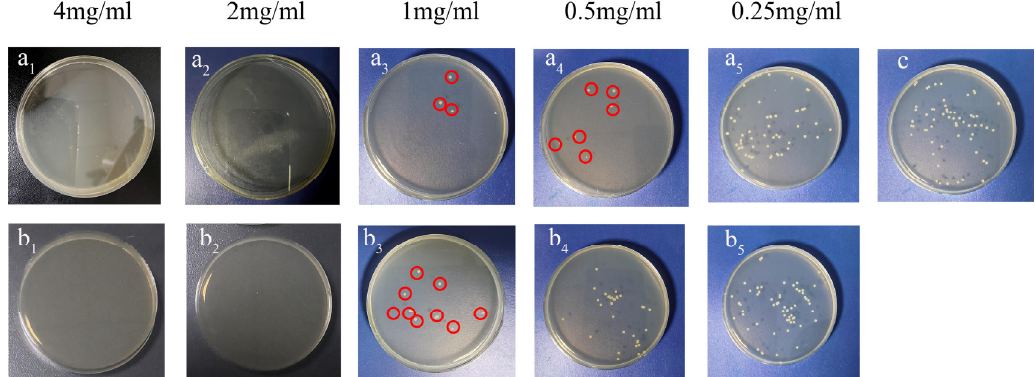
Figure 9. Antibacterial activity of the samples: colony count results of the bacterial suspension containing M-NH 2 -CIT@CIT ( a 1 – a 5 ), M-CIT ( b 1 – b 5 ), and the control group ( c ).